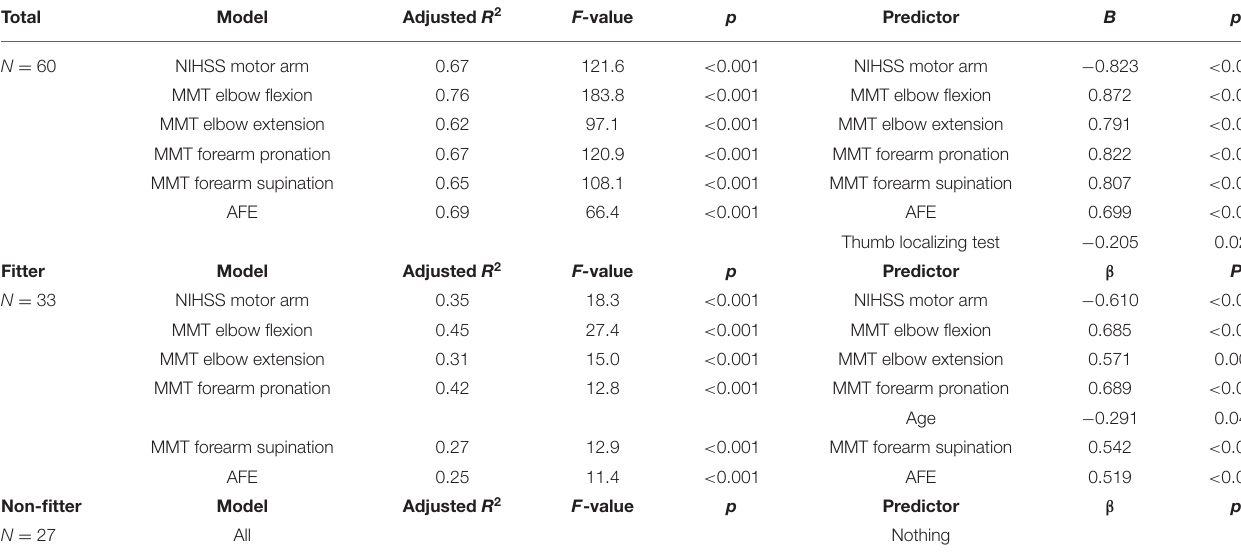
TABLE 4 | Linear Regression Statistics for Predictors of FMA-UE at 3